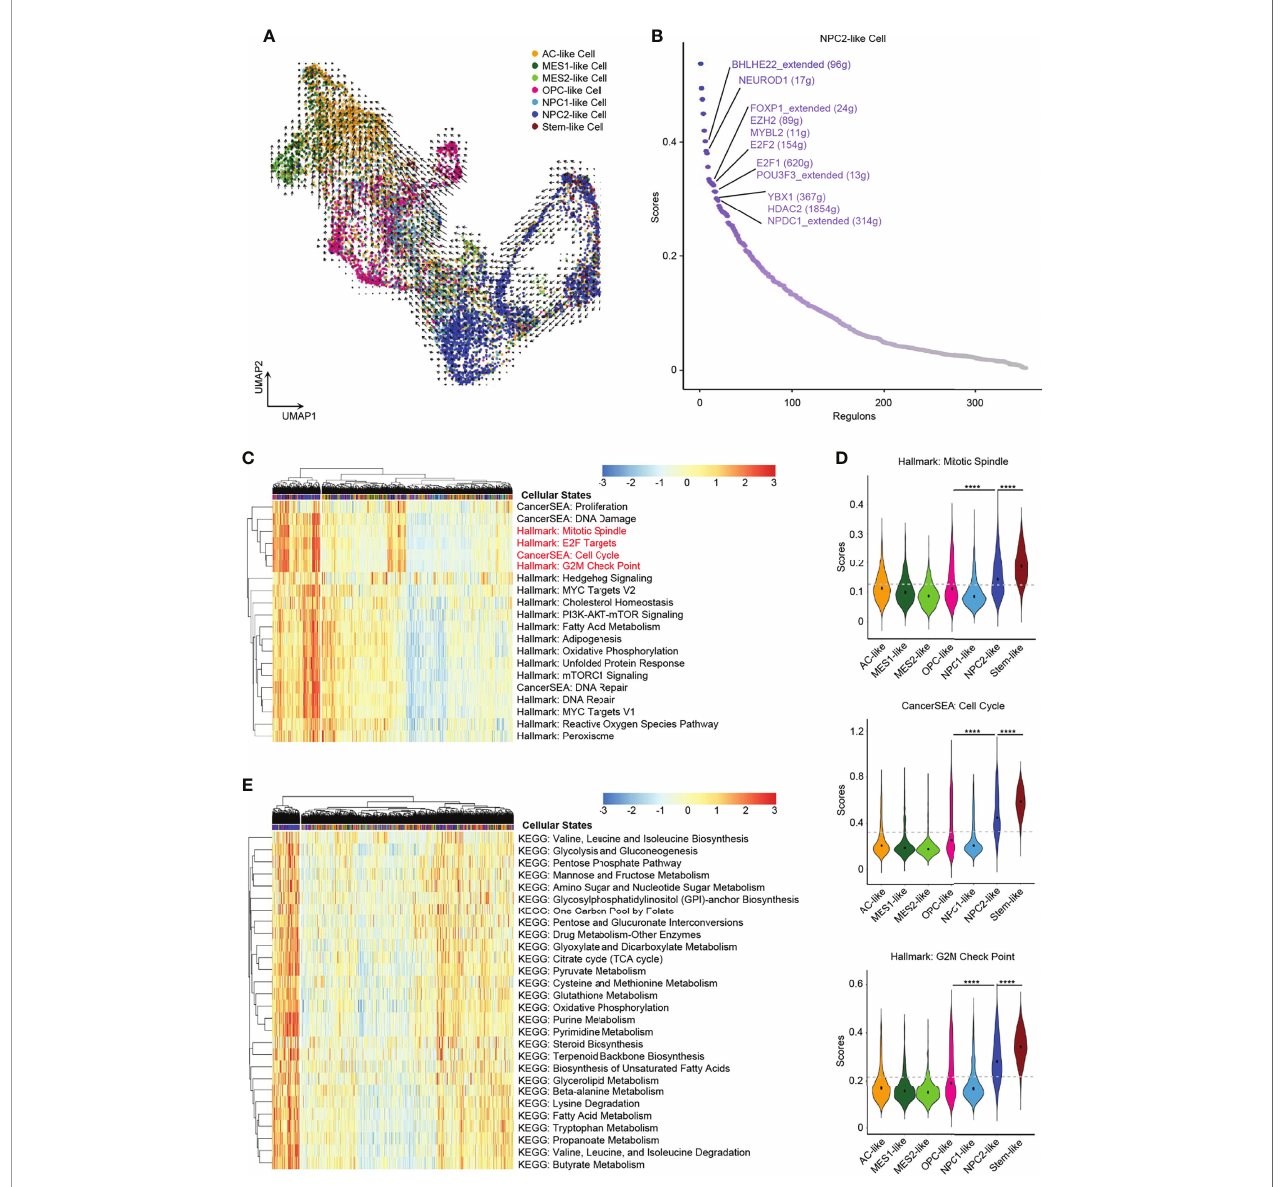
FIGURE 3 | NPC2-like cells, the original root cell of GBM. (A) Inferred developmental trajectory of the six GBM tumor cell cellular states by RNA velocity, which implied that the NPC2-like cells, like stem-like cells, were the root cell of the developmental trajectory. (B) The activated regulons ranked by regulon speci fi city score from high to low in the NPC2-like cells. (C) Heatmap of cancer-speci fi c gene sets in the six cellular states and stem-like cells. (D) Violin plot of the Mitotic Spindle, Cell Cycle, and G2M Check Point gene set scores in the six cellular states and stem-like cells. NPC2-like cells, like stem-like cells, were in the cell cycle. (E) Heatmap of metabolism gene sets in the six cellular states and stem-like cells. NPC2-like cells had a higher metabolism level than other cellular states. Gray dash line, average score; **** p < 0.0001. See also Supplementary Figure 3 and Supplementary Table 4